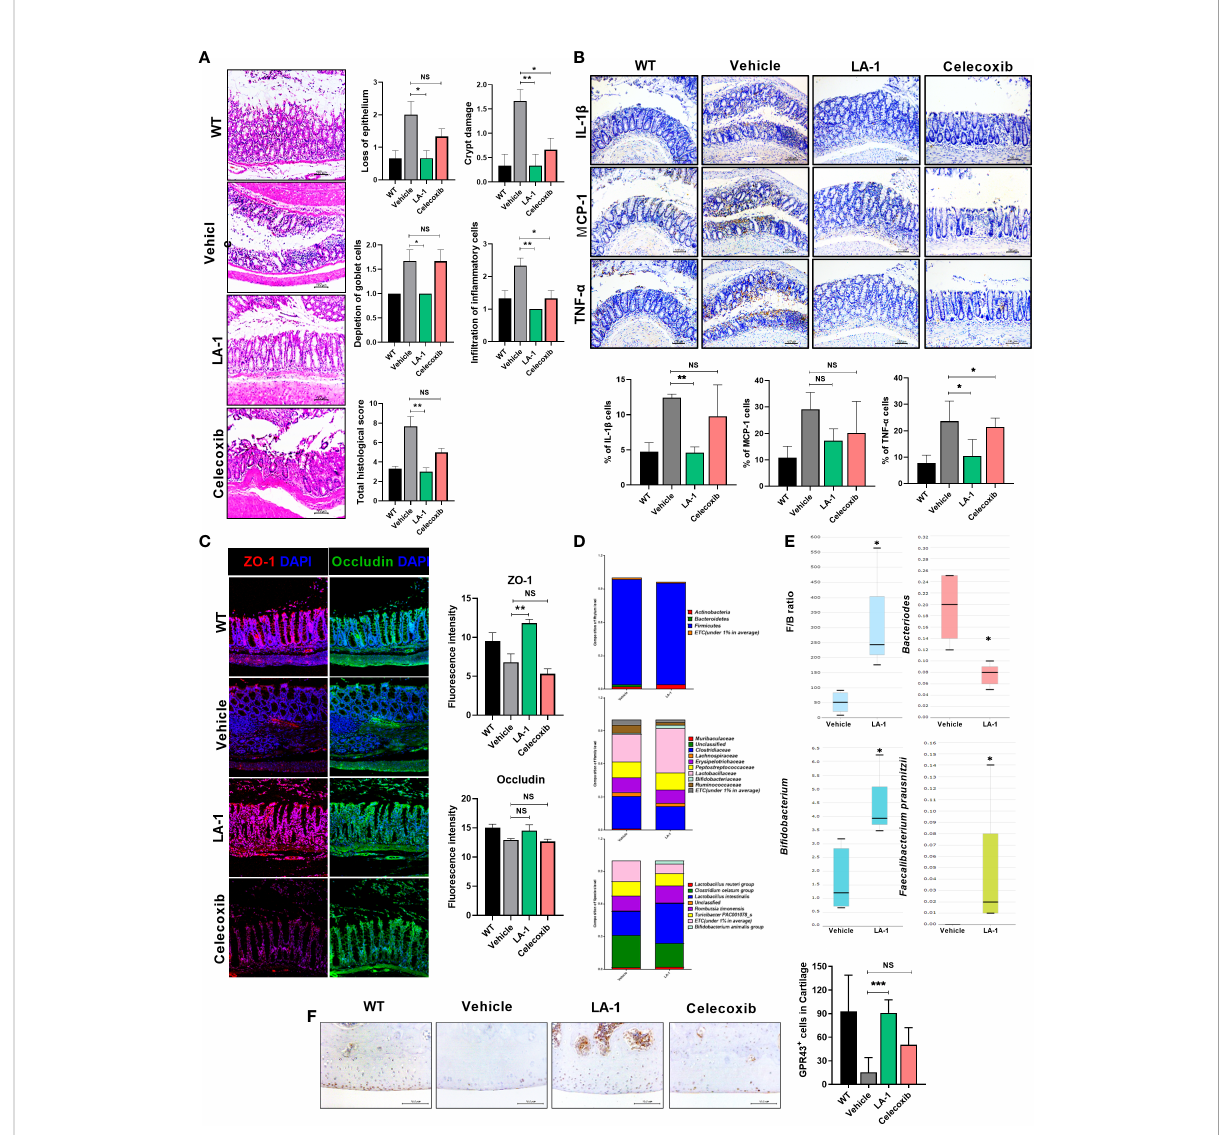
FIGURE 3 LA-1 improves the imbalanced intestinal environment and microbiome. (A) Representative images show H&E staining of the intestine in the WT, vehicle, LA-1, and celecoxib groups (magni fi cation ×200). (B) In fl ammatory factor expression in intestinal epithelial cells was determined by IHC in each group (magni fi cation ×200). (C) Tight junction protein (TJP) expression in intestinal epithelial cells was increased by LA-1 (magni fi cation ×200). (D) The feces of OA rats had different phyla, family, and species phenotypes from those treated with LA-1, and a relatively high proportion of bene fi cial bacteria was found in the feces of LA-1-treated rats. (E) LA-1 altered the F/B ratio and the population of butyrate-producing bacteria. (F) LA-1 increased the level of the short-chain fatty acid receptor G-protein-coupled receptor 43 (magni fi cation ×400). Data are means ± SD (* p < 0.05, ** p < 0.01, *** p < 0.005), ns, not signi fi